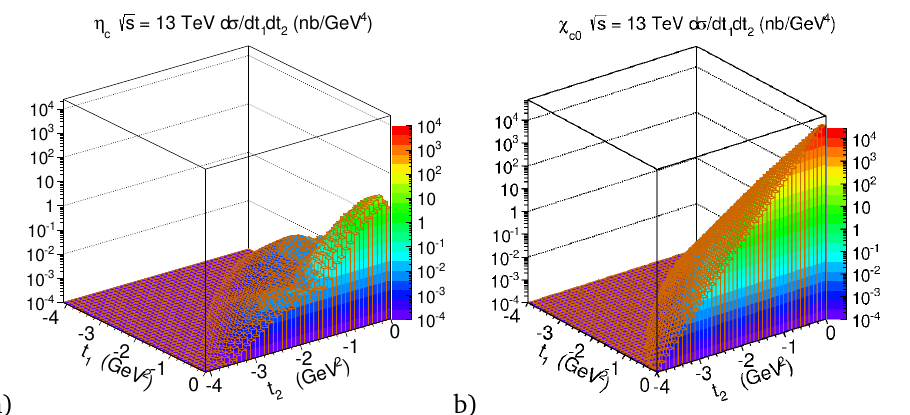
Figure 3: Cross section for a) η Here we used the PST